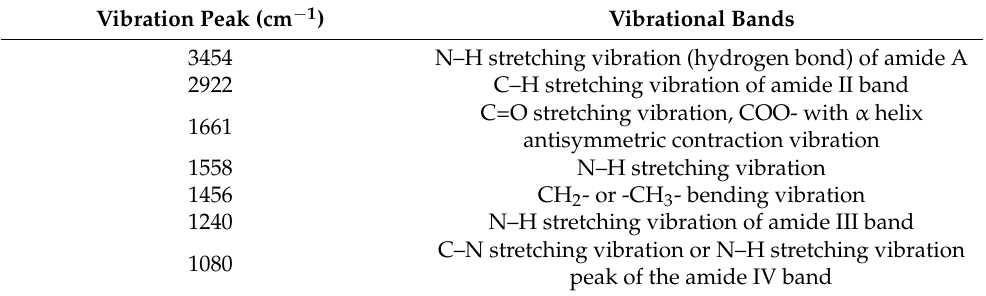
Table 1. Main vibrational bands in infrared ray (IR) spectra before and after